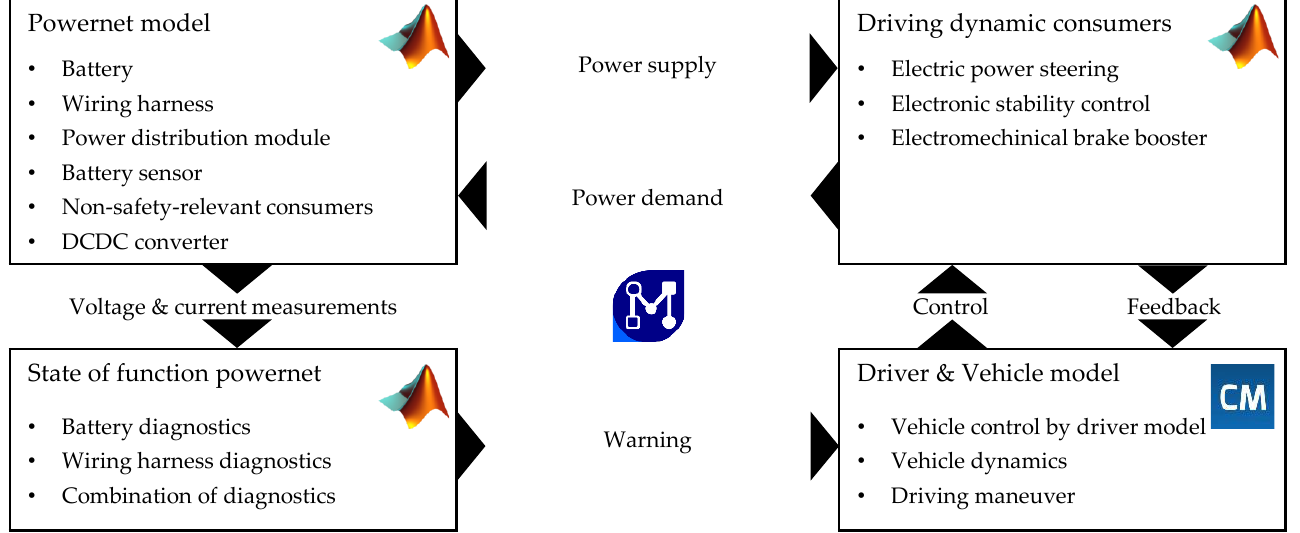
Figure 6. Design and interfaces of the simulation environment to validate the SOFPN using three different simulation